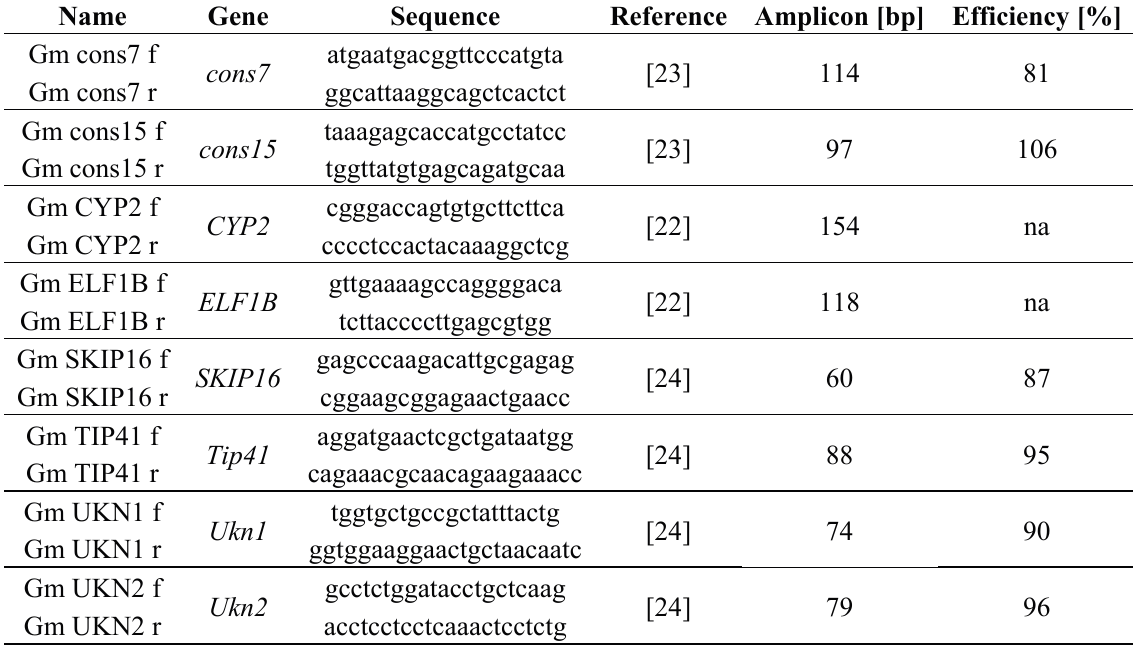
Table 4. Primers used in qRT-PCR for G.max